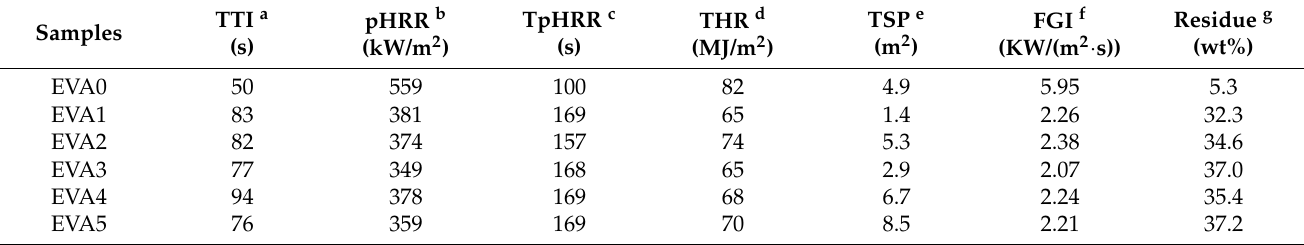
Figure 8. Heat release rate curves of neat EVA and EVA/MH composites. Table 5. Cone calorimetric data of neat EVA and EVA/MH